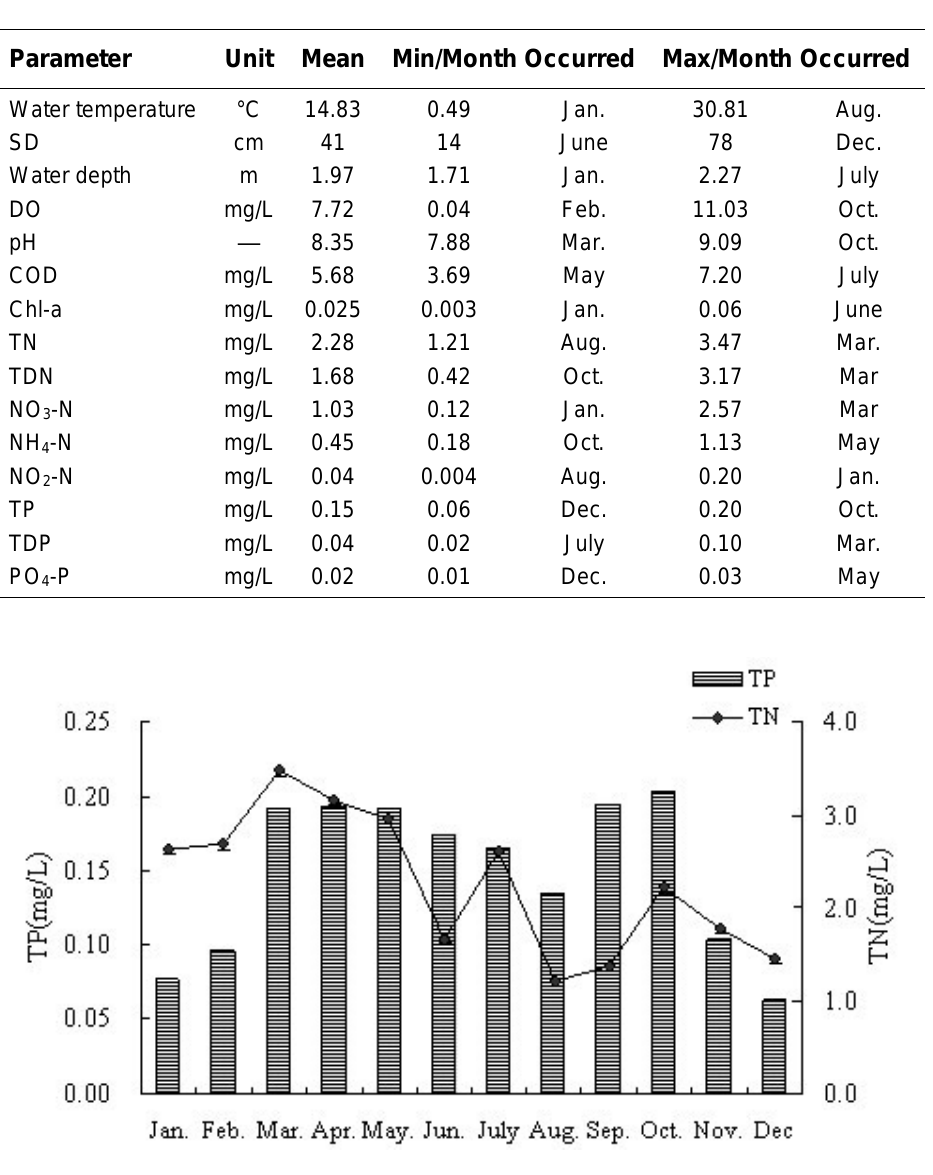
FIGURE 5 . Seasonal variations of TN and TP concentrations in Gonghu Bay